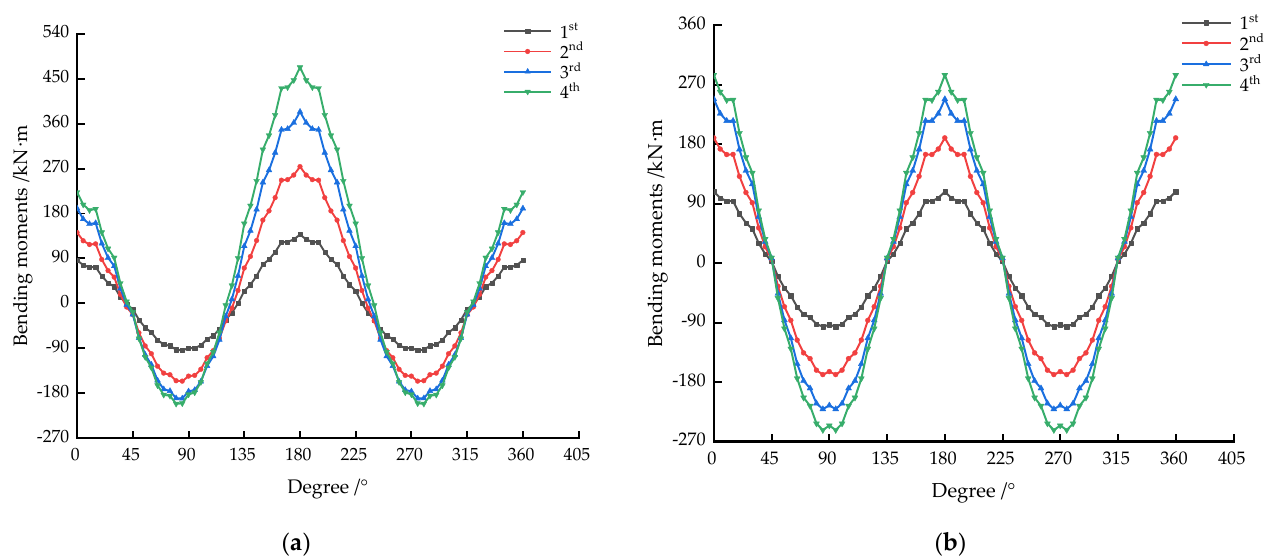
Figure 5. Simulated bending moments under different loading conditions (unit: kN·m): ( a ) Beam- spring model; ( b ) modified uniform rigidity ring model.